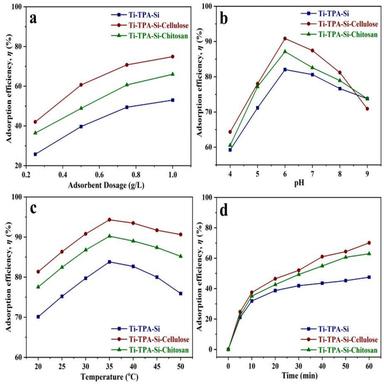
(a) Effect of adsorbent dosage, (b) pH, (c) temperature, and (d) time on the adsorption efficiency of Ti-TPA-Si, Ti-TPA-Si-C, and Ti-TPA-Si-CS.